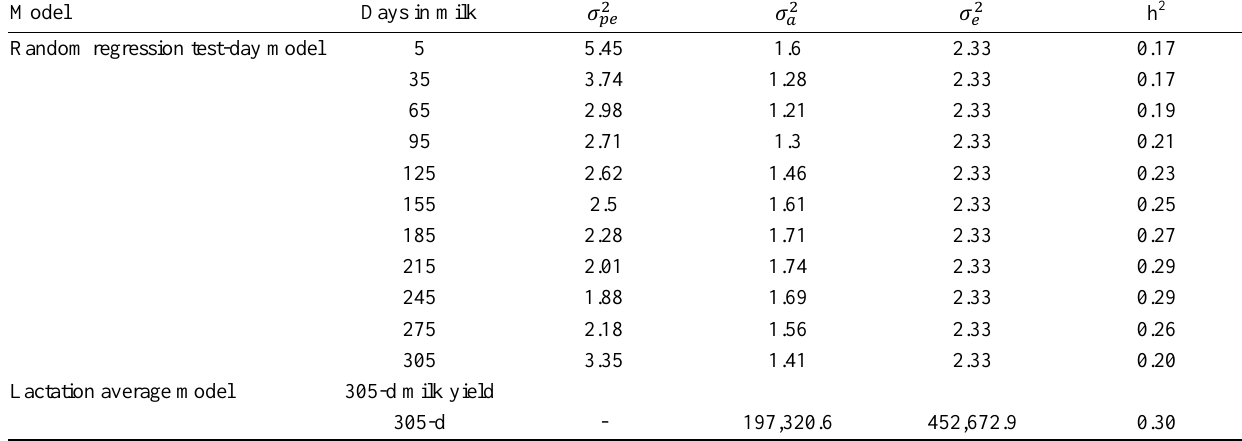
Table 2. Estimates of permanent environmental ( lactation average and random regression test-day models